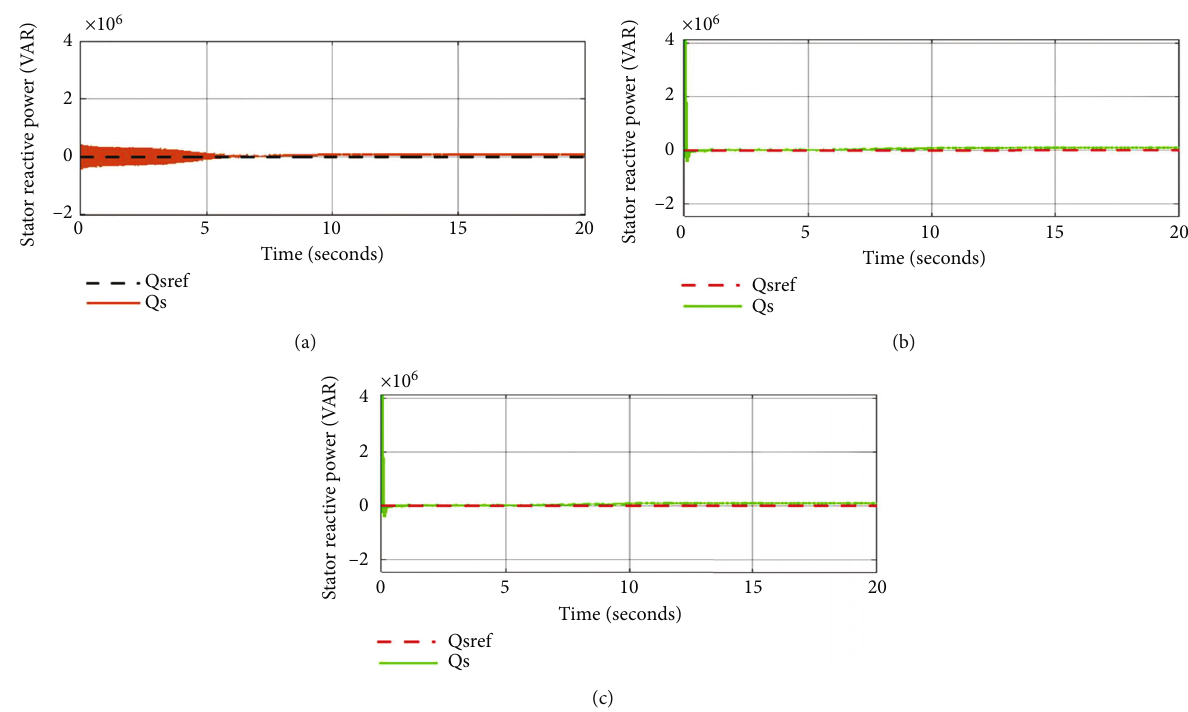
Figure 17: (a – c) Stator reactive powers with their